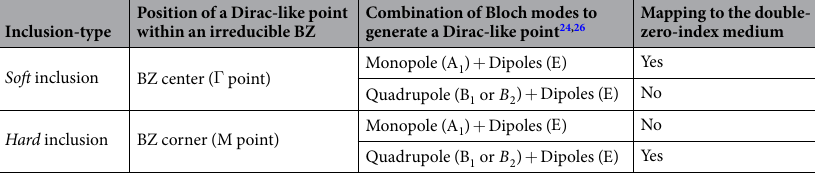
Table 1. Zero-index mapping condition for a square crystal with C 4v